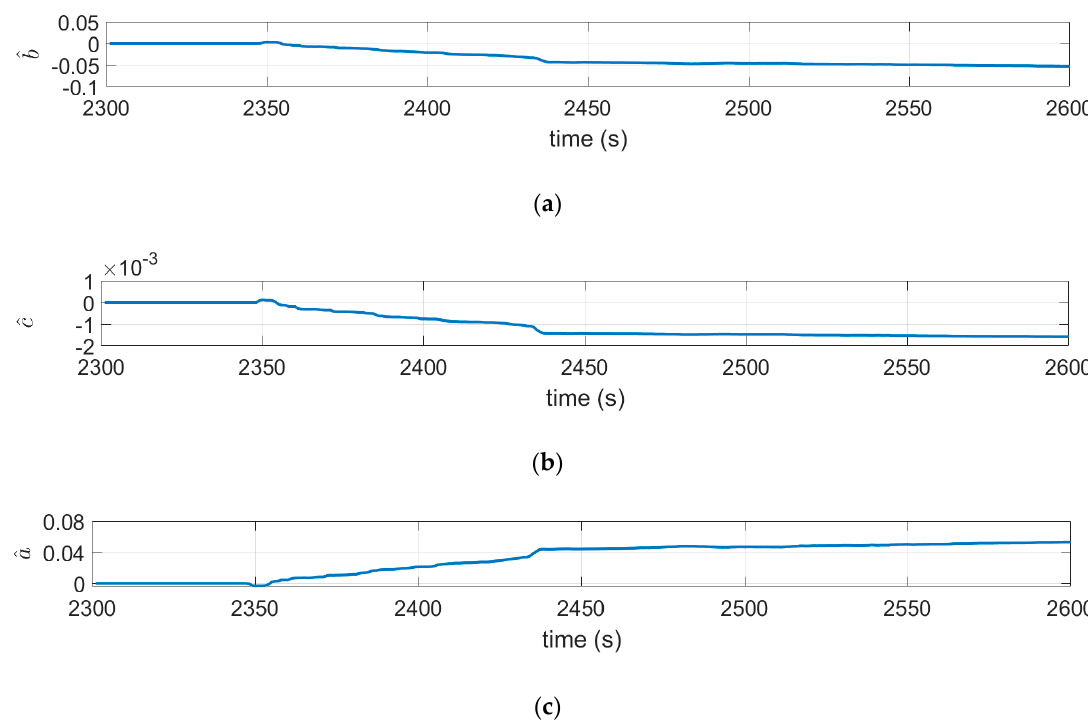
Figure 21. Experimental adaptation of three unknown parameters during the gliding test in the sea: ( a ) estimation of parameter 𝑏 , ( b ) estimation of parameter 𝑐 , and ( c ) estimation of parameter 𝑎 .